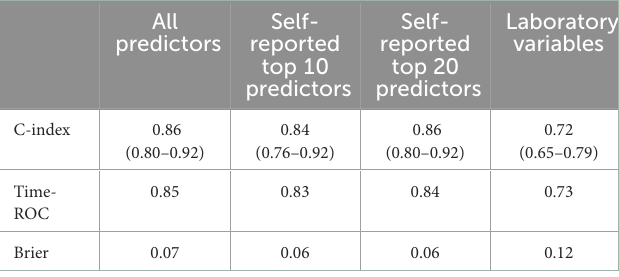
TABLE 3 Performance of the RSF models in the internal validation cohort.